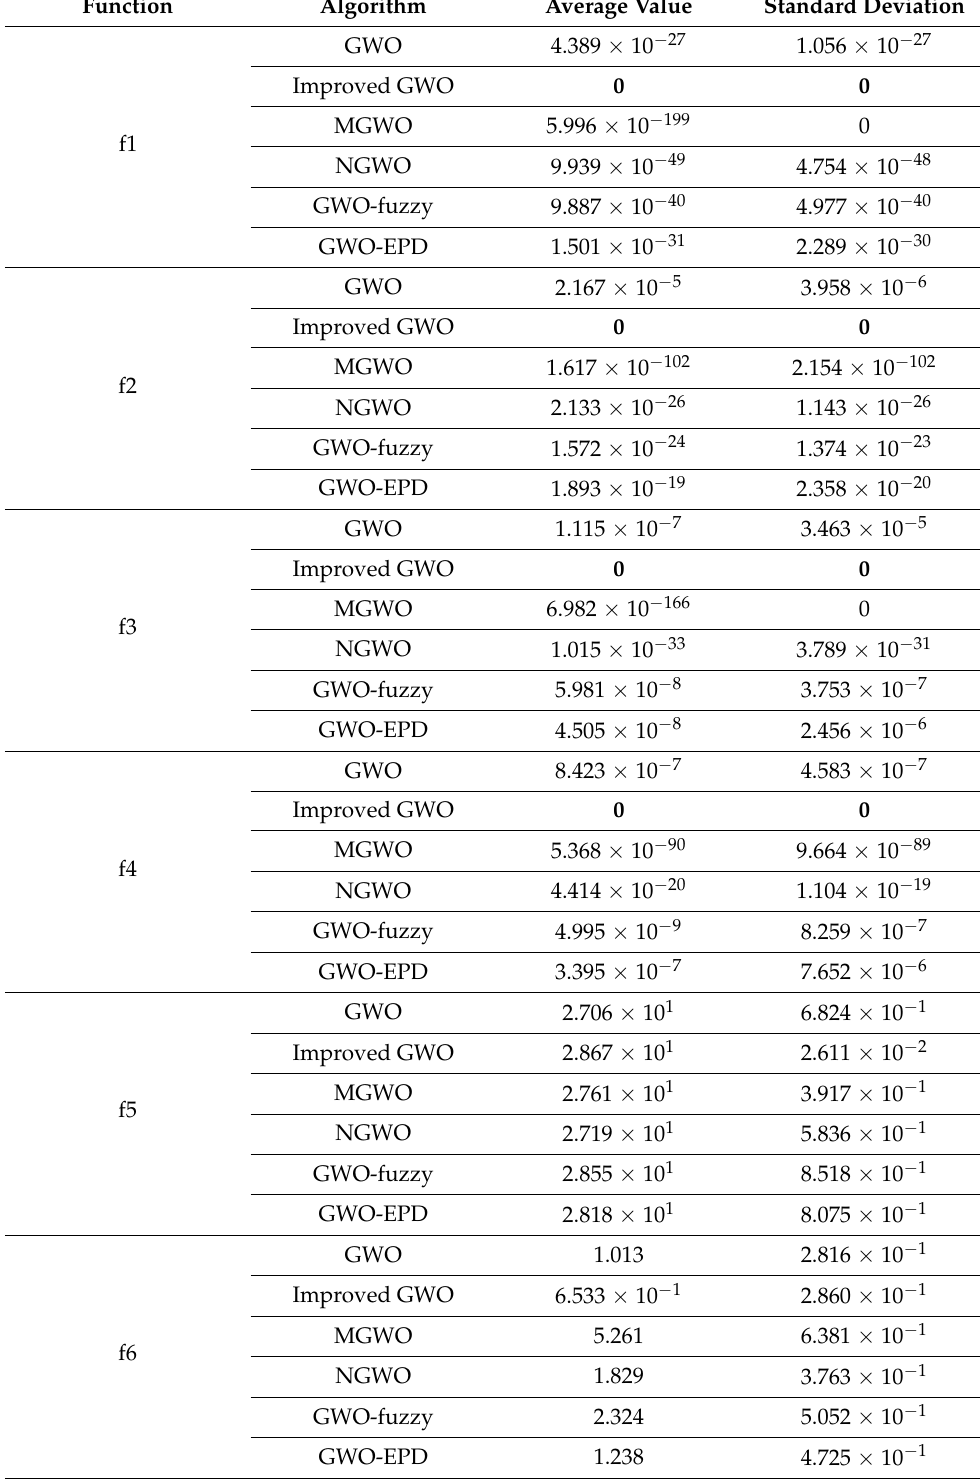
Table 3. Test functions